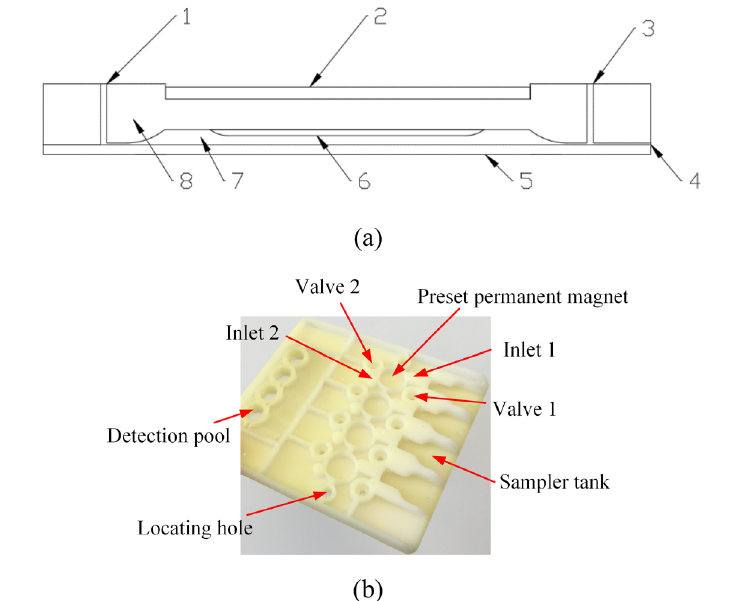
Figure 4. Magnetic beads preset microfluidic chip. ( a ) Structural schematic diagram. ( b ) Chip structure.